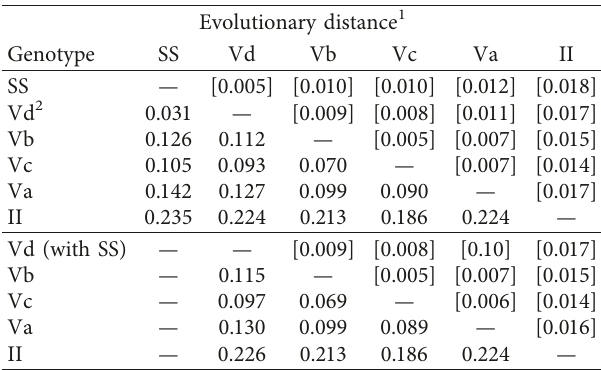
Table 3: Mean evolutionary distance between the complete nu- cleotide sequences of the fusion gene of the study sample, NDVs of genotype V, and the LaSota strain. Evolutionary distance 1